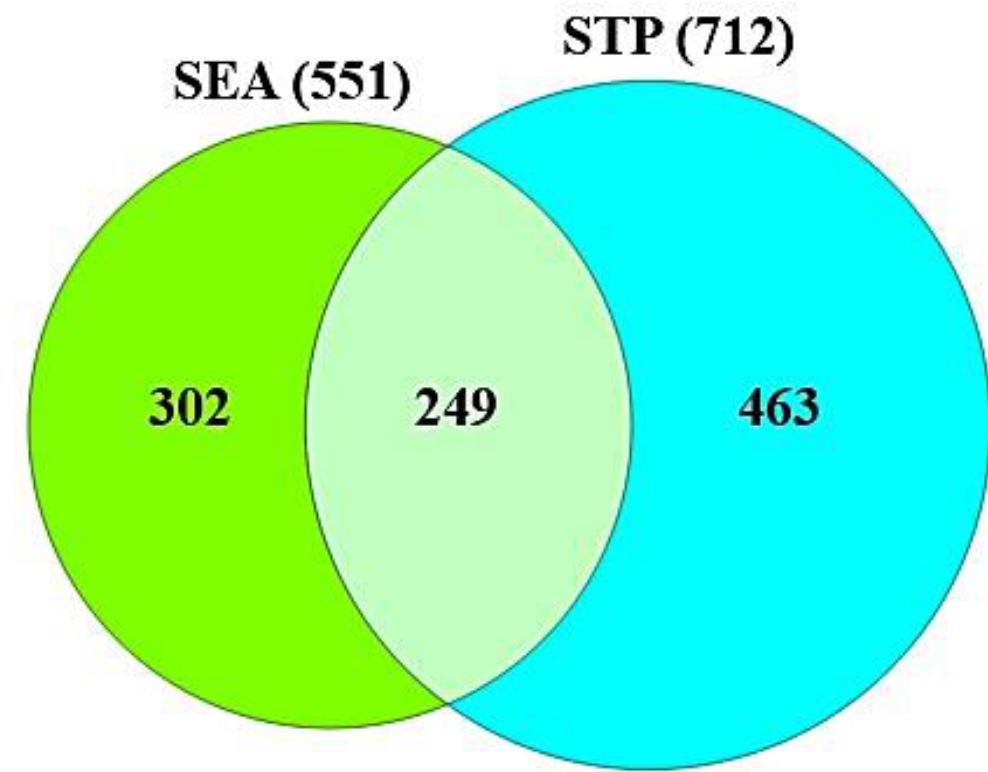
Figure 2. The overlapping 249 targets between 550 from SEA and 712 targets from STP.